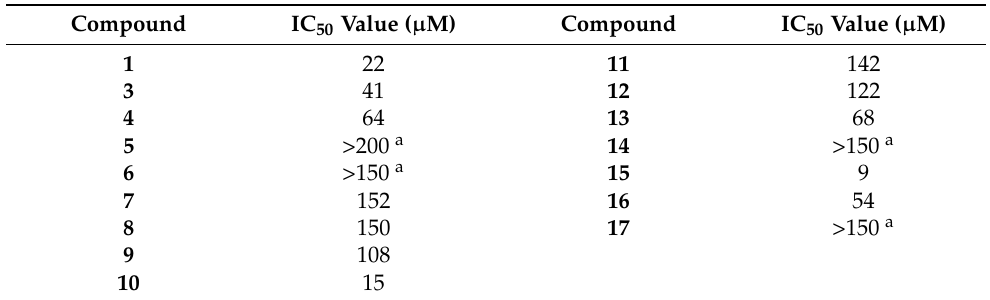
Table 1. Effect of the derivatives on LOX-3, expressed as IC 50 ( µ M), after 5 min of incubation.